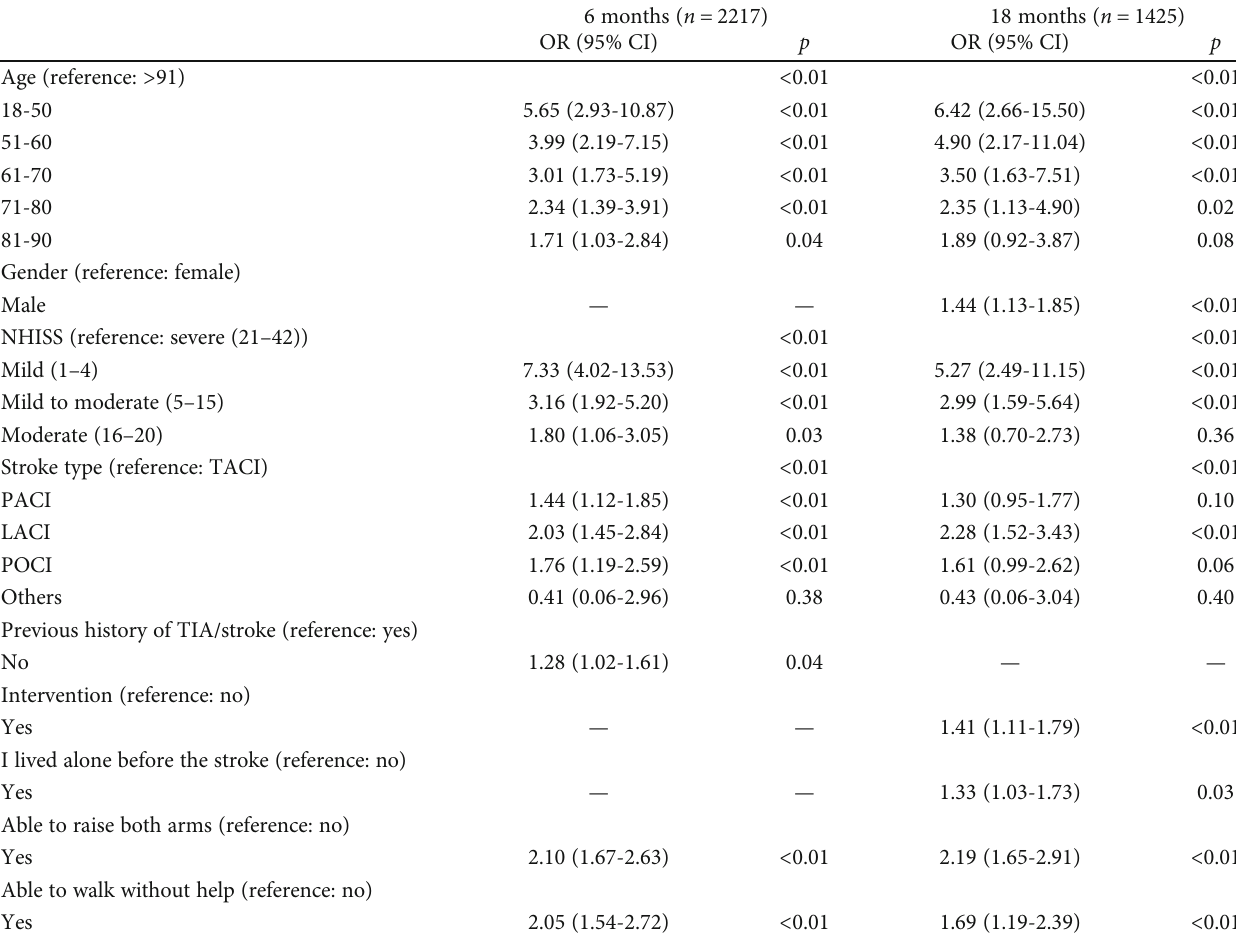
Table 5: Final model for poststroke independence at 6 and 18